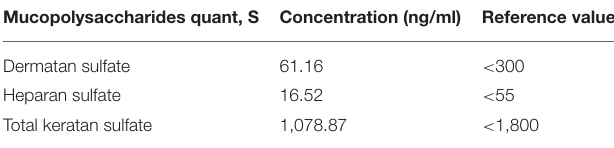
TABLE 2 | Results of mucopolysaccharides quant assay performed on patient’s